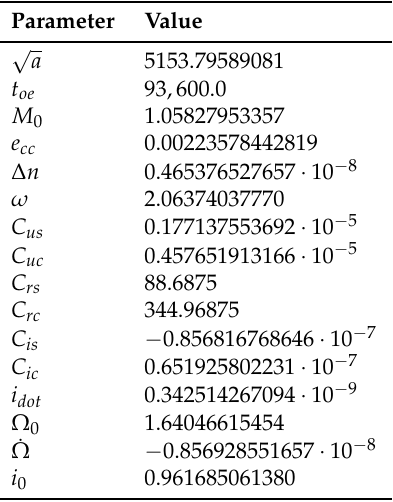
Table 5. Satellite PRN14 ephemeris data.